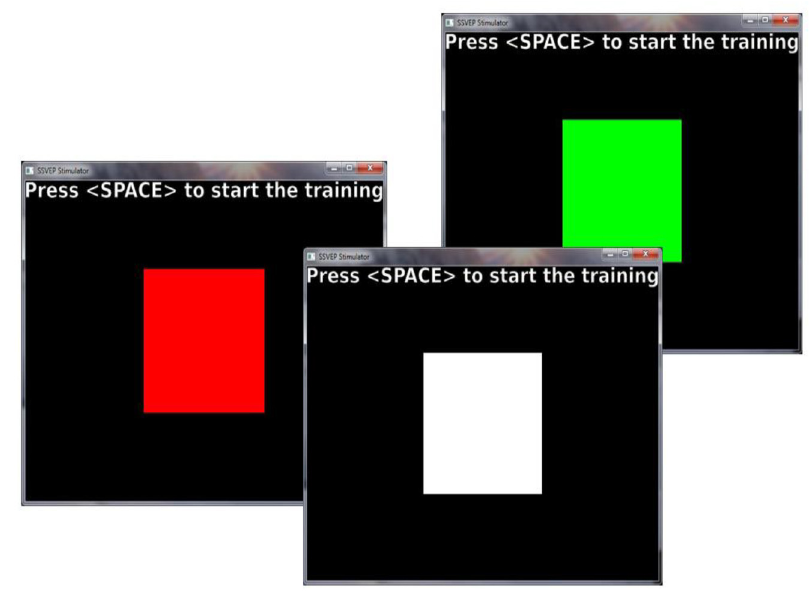
Figure 1. Disposition of the 6 electrodes used according to the international 10–20 system for elec- trode placement.